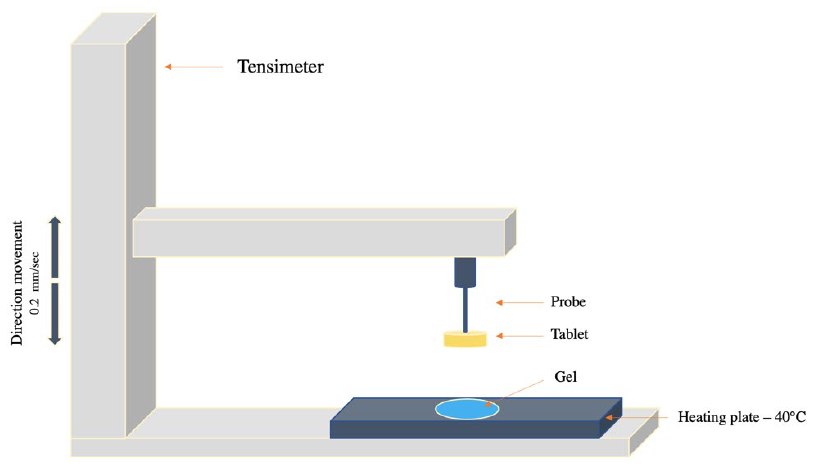
Figure 1. Schematic representation of experiment used for the tensile